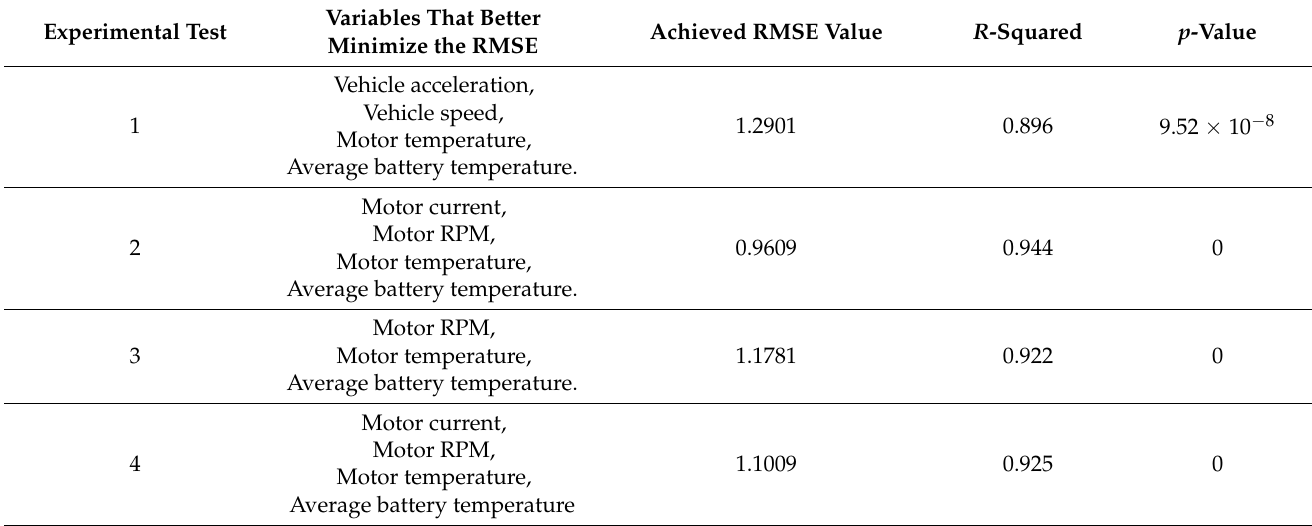
Table 3. Variables that best minimize the RMSE for the second transmission shift.